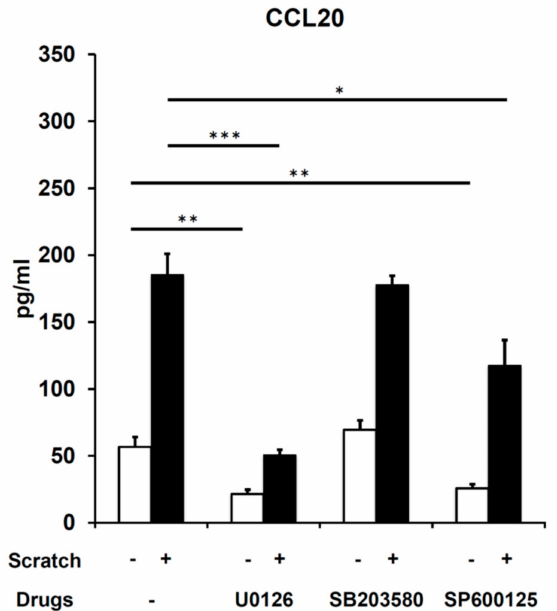
Figure 4. Scratch injury induces phosphorylation of ERK1 / 2, JNK, and p38 MAPK at 1 h after scratching. Phosphorylation of ERK1 / 2, JNK, and p38 MAPK was examined by western blotting in non-scratched control and scratched keratinocytes. Representative blot images of three independent experiments ( A ) and the relative expressions of phosphorylated proteins ( B ) are shown. * p < 0.05. ** p < 0.01. *** p < 0.001.